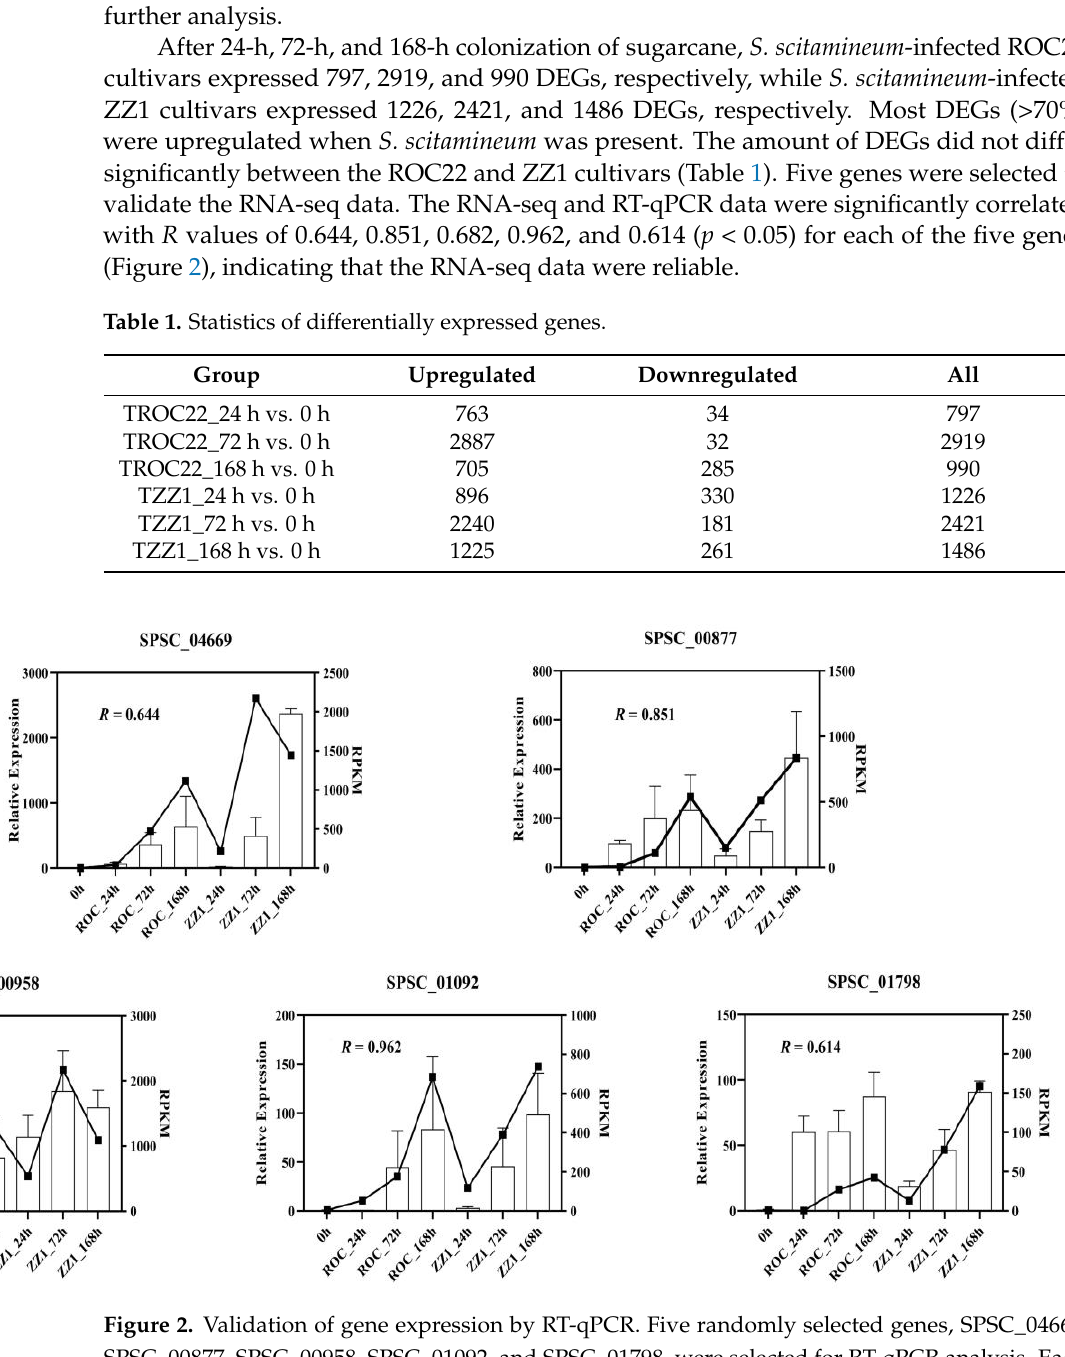
Figure 1. Visualization and quantification of S. scitamineum in sugarcane sprouts. ( A ) Sugarcane sprouts inoculated with S. scitamineum teliospores at different time points. The brown parts on the sprouts are the inoculation sites. The upper left corner is an enlarged view of the region indicated by the red box. Bars = 50 μm. ( B ) Quantification of S. scitamineum bE gene copies in sugarcane sprouts, and this gene played a role in haploid sporidia mating. The DNA contents of all samples were 100 ng. After 168-h post-inoculation, the number of S. scitamineum copies differed significantly between ROC22 and ZZ1 (* p < 0.05). The sprouts without inoculation were considered as controls. Three biological replications were conducted, and each replication contained five sprouts.